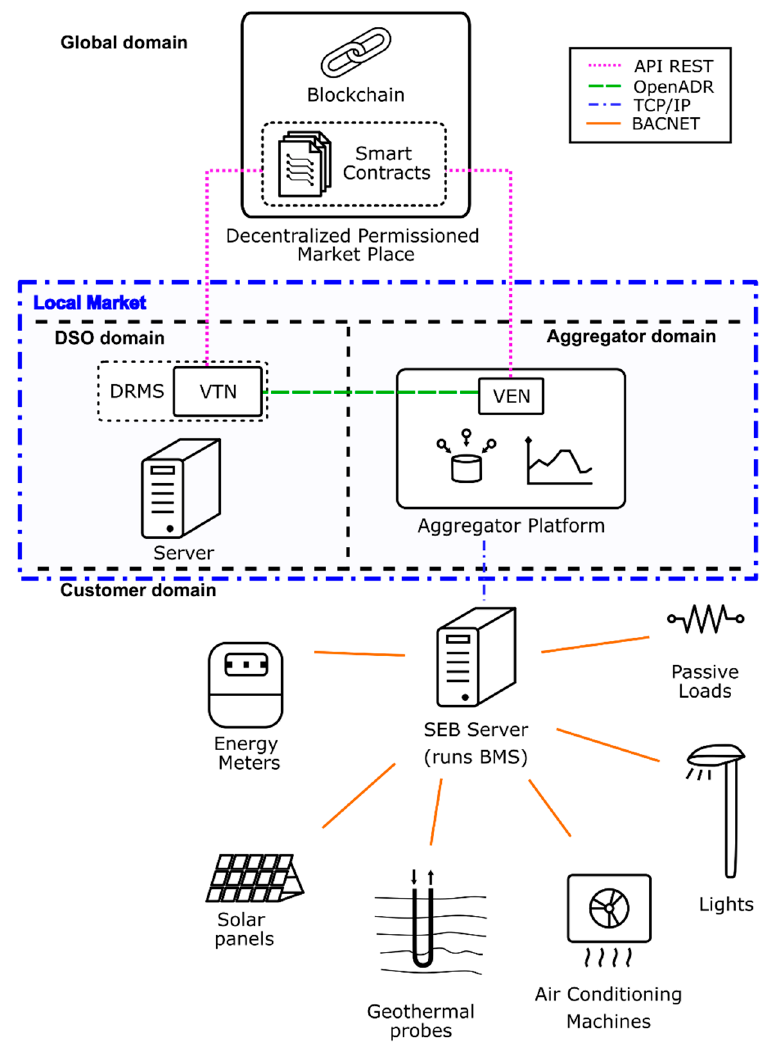
Figure 5. Scheme of PoC.